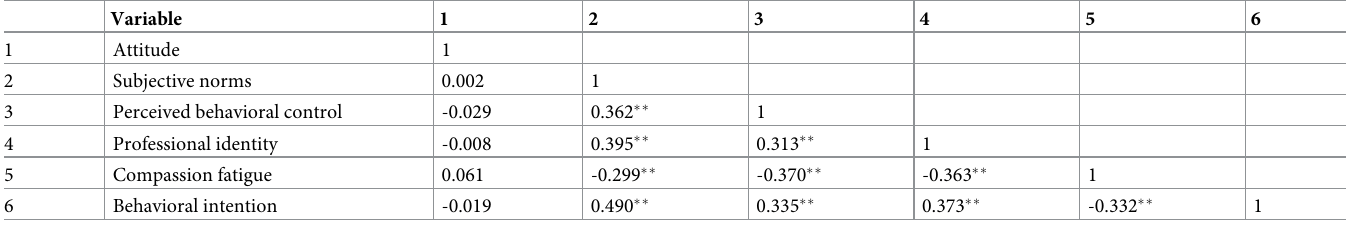
Table 3. Correlations among attitude, subjective norms, perceived behavioral control, professional identity, compassion fatigue, and behavioral intention. Variable